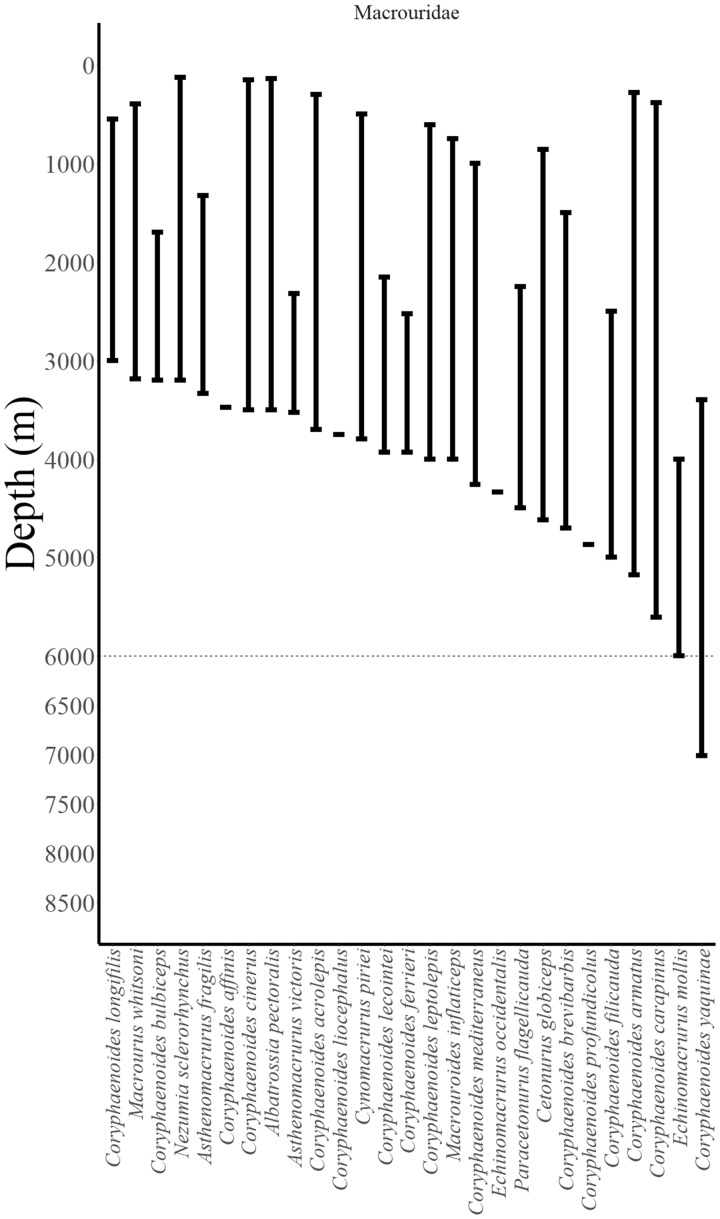
Reported depth distributions of deep-dwelling fishes (collections >3000 m) by family (Macrouridae). Abyssal–hadal boundary at 6000 m shown as dotted line. Data from FishBase (Froese and Pauly 2014) checked in the primary literature (Nielsen 1977; Andriashev and Stein 1998; Nielsen et al. 1999; Chernova et al. 2004; Chernova 2006; Duhamel and King 2007; Moller and King 2007; Jamieson et al. 2009; Linley et al. 2016, 2017; Gerringer et al. 2017b). See Supplementary Note 1 for notes on record verifications.